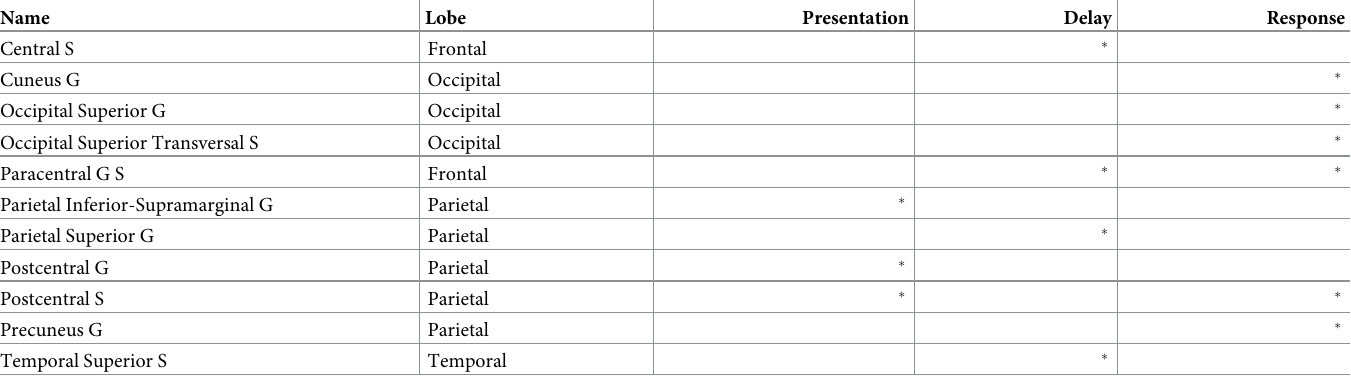
Table 1. Representation of novel sequences. Anatomical region suffixes indicate gyrus (G) or sulcus (S). Asterisks ( � ) represent significant evidence for the item-position sequence representation model reaching the lower bound of the noise ceiling in any of the three task phases: presentation, delay, and response. The lower noise ceilings were significantly greater than zero for all regions displayed in the table ( df = 21, p < 10 − 3 ); see see Noise ceiling estimation in Methods for